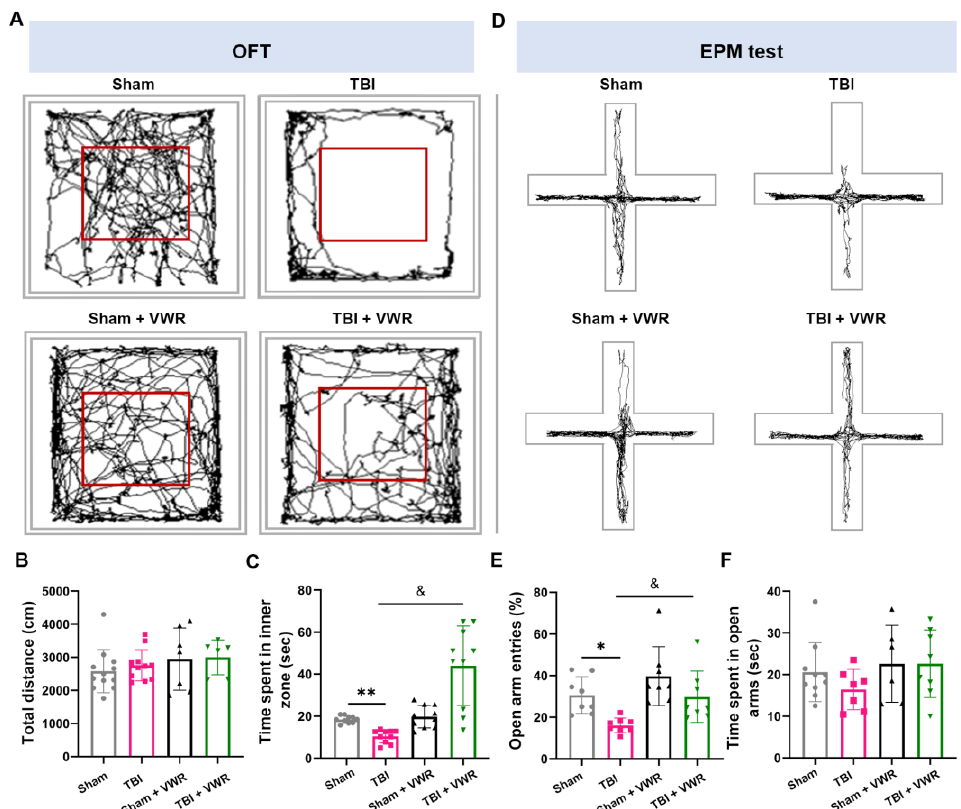
Figure 2. VWR eased the anxiety behavior of TBI mice. ( A , D ) Representative traces of locomotor activity in the OFT and EPM test. ( B ) No significant difference in total distance was observed between the four groups in the open field. ( C ) TBI significantly decreased the time that mice spent in the inner zone of the open field, while VWR significantly reversed it. ( E ) TBI significantly decreased while the VWR significantly increased the open-arm entries of mice. ( F ) The total times spent in open arms were similar between the four groups. One-way ANOVA, Post hoc Sidak’s multiple comparisons tests; n = 8. ** p < 0.001, * p < 0.05 vs. Sham, & p < 0.05 vs. TBI. VWR, voluntary wheel running; TBI, traumatic brain injury; OFT, open field test; EPM, elevated plus maze.